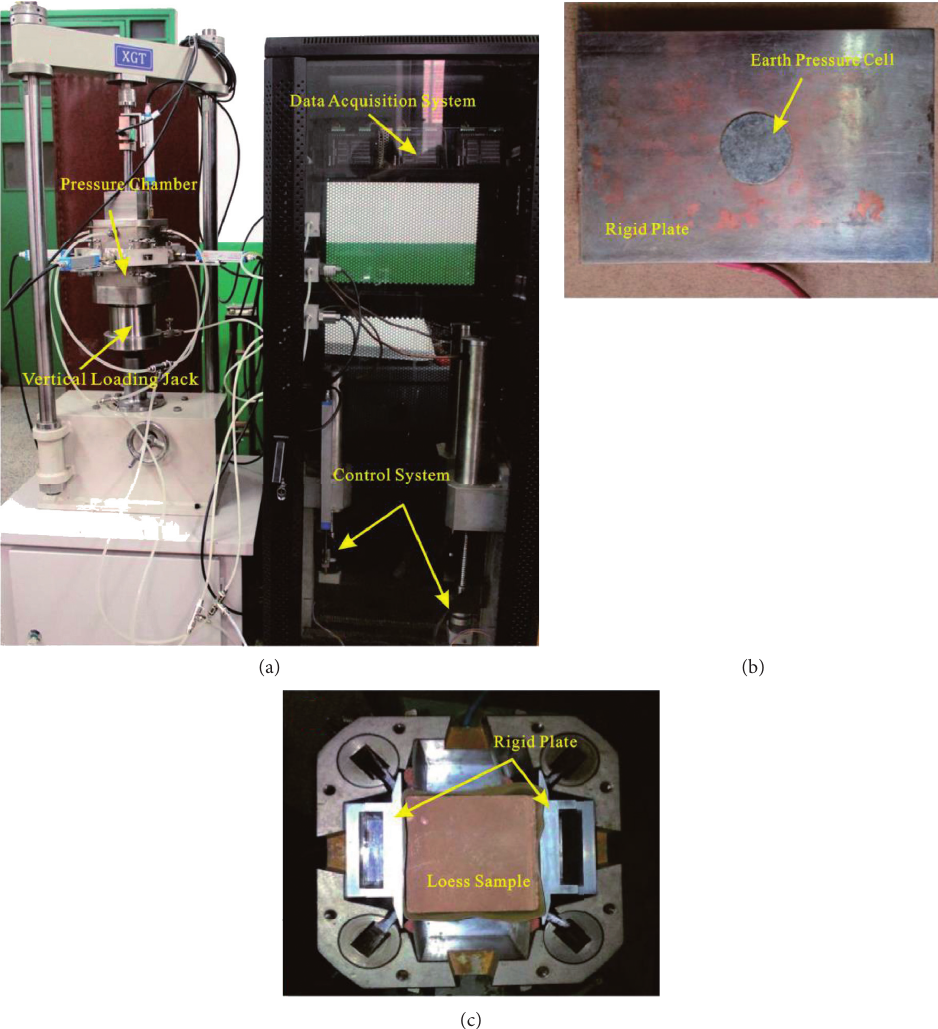
Figure 1: Upgraded XGTtrue triaxial apparatus: (a) true triaxial system, (b) smooth rigid plates embedded with the Earth pressure cells, and (c) the sample loading in the pressure chamber, which is laterally confined by b and a water